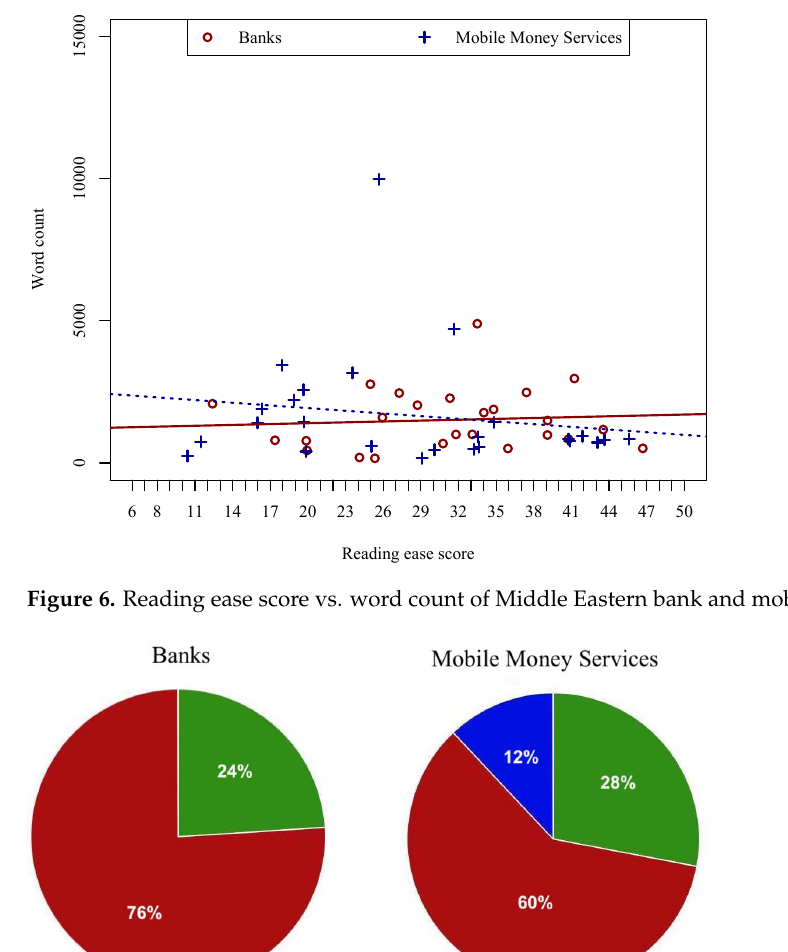
Figure 5. Reading grade level vs. word count of Middle Eastern bank and mobile money policies.